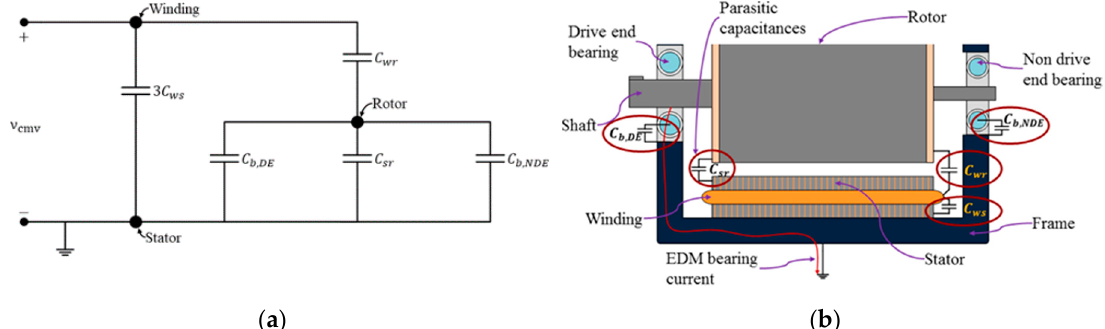
Figure 3. Motor behavior at high frequencies. ( a ) High frequency capacitive model of an electric motor. ( b ) Location of the parasitic capacitances with respect to motor geometry.